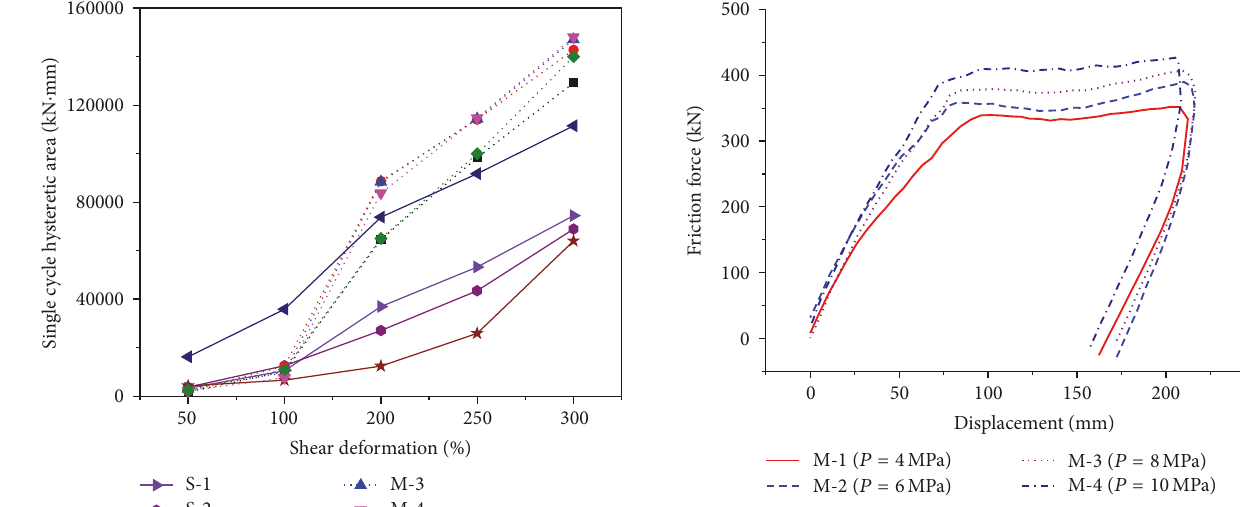
Figure 14: Relationship of friction force and displacement.